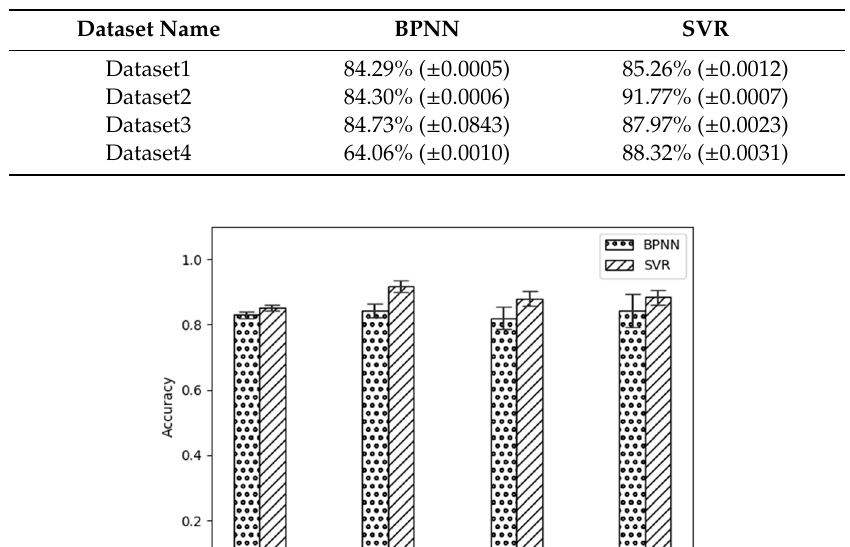
Table 2. Wind turbine fault detection rates with BPNN and SVR.